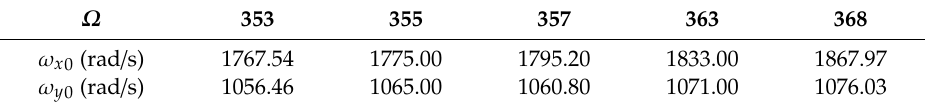
Figure 21. For δ 0 = 4.0 μ m, numerical bifurcation diagrams of local maxima ( a ) x ( τ ) and ( b ) y ( τ ) when Ω sweeps up (black dots) and down (red dots) around 100-200 rad/s.